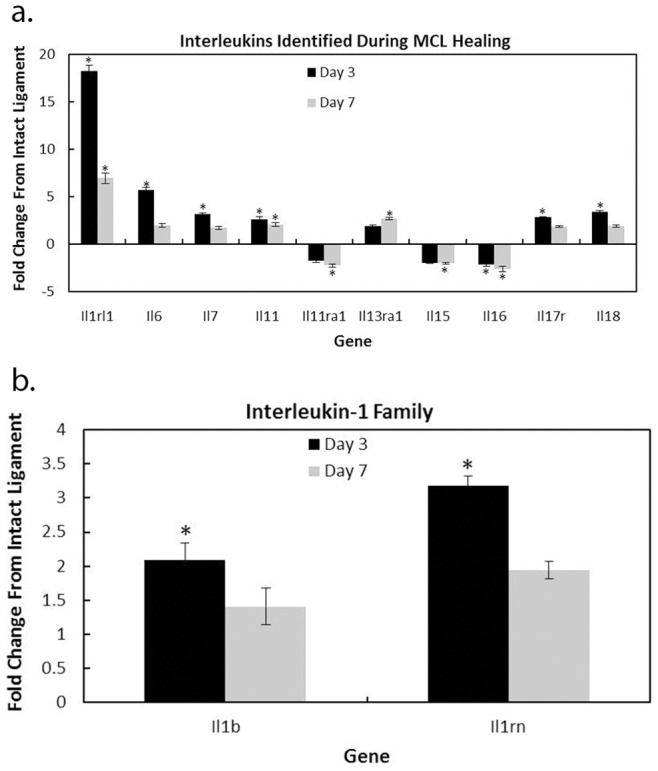
Microarray results identifying specific interleukins modulated at days 3 and/or 7 post-injury.A total of 12 interleukins were significantly modulated (2 fold greater than normal and q-value <.05) compared to the intact control. Of those 12, 6 were up-regulated at day 3 only (il6, il7, il17r, 1l18, il1b, and il1rn), 1 up-regulated at day 7 only (il13ra1), 1 down-regulated at day 7 only (il11ra1), 2 up-regulated at both day 3 and 7 (il1rl1, il11), and 1 down-regulated at both day 3 and 7 (il16). Interleukins regulated during healing were both pro- and anti-inflammatory (a). Members of the il1 family were significantly regulated with healing (b). Microarray data are compared to the normal intact ligament and expressed as fold change ± S.D. * indicate fold change ≥2 from the intact control.